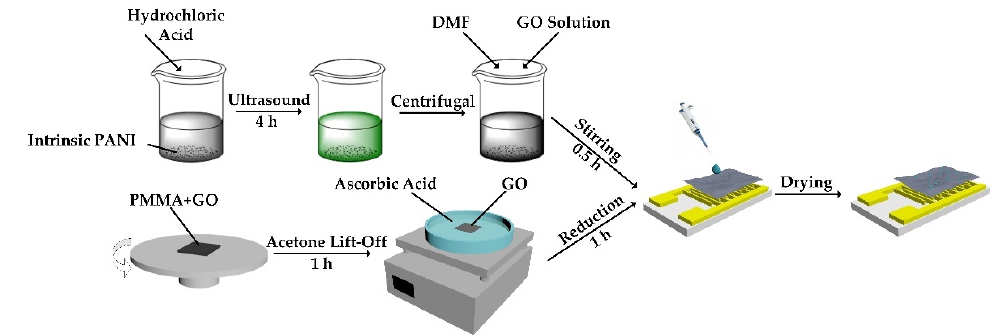
Figure 1. The schematic of the device fabrication process.